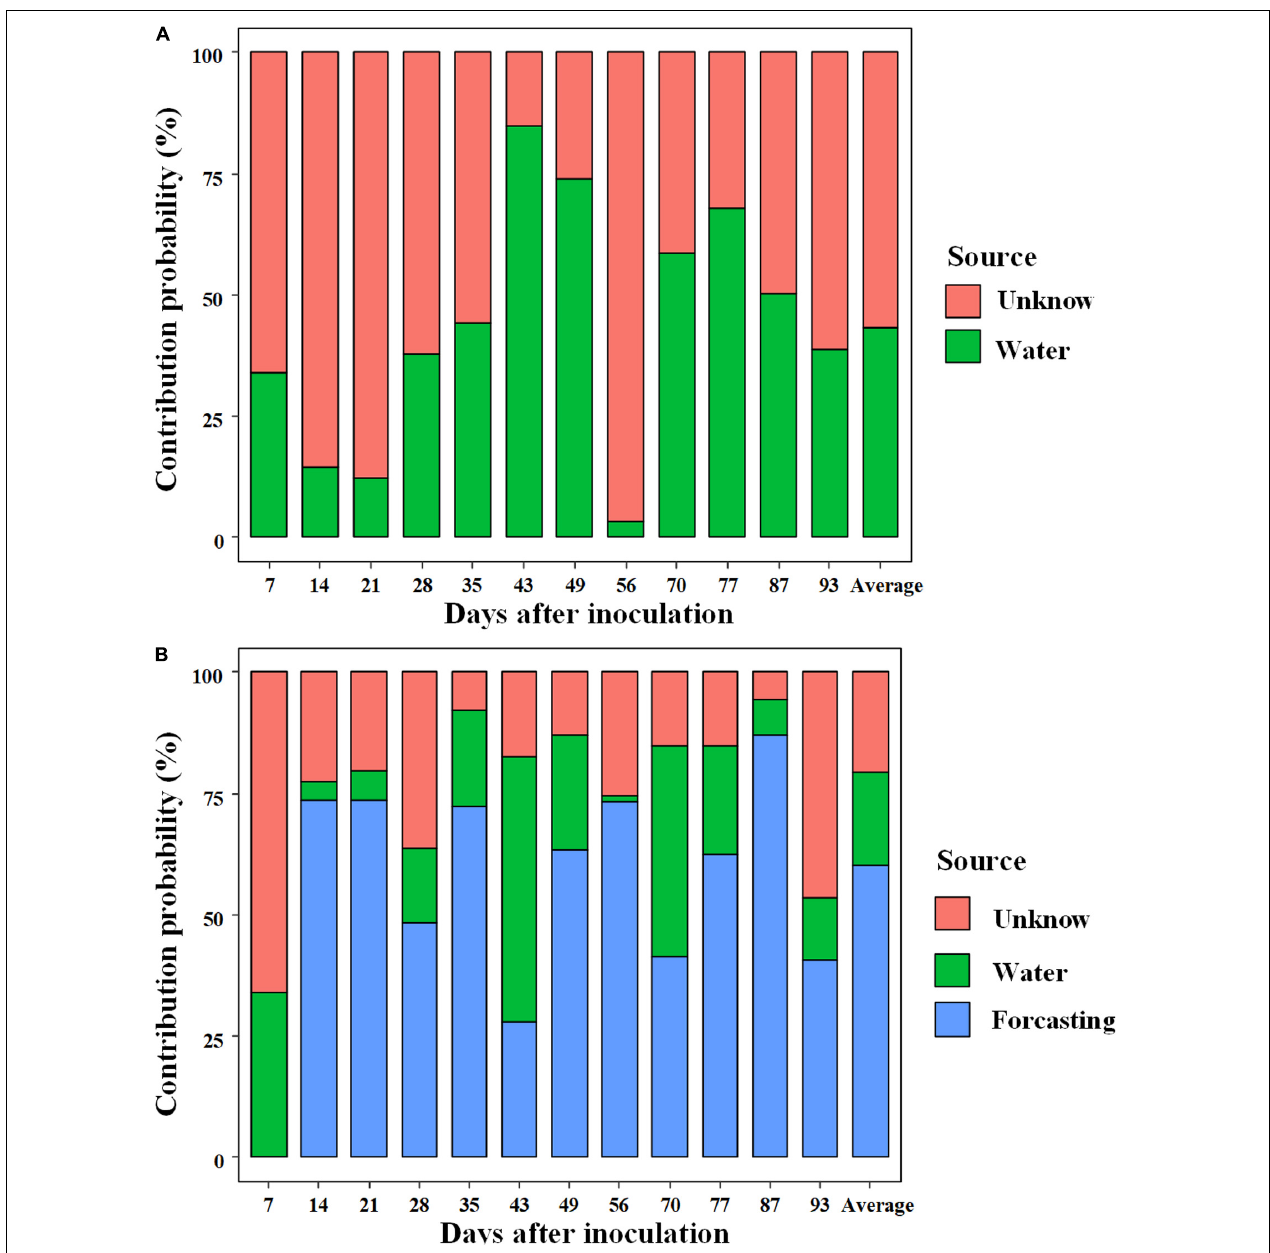
FIGURE 5 | SourceTracker analyzes the relative contribution of external (rearing water) (A) and internal (gut commensals of the adjacent younger shrimp) sources (B) to the shrimp gut